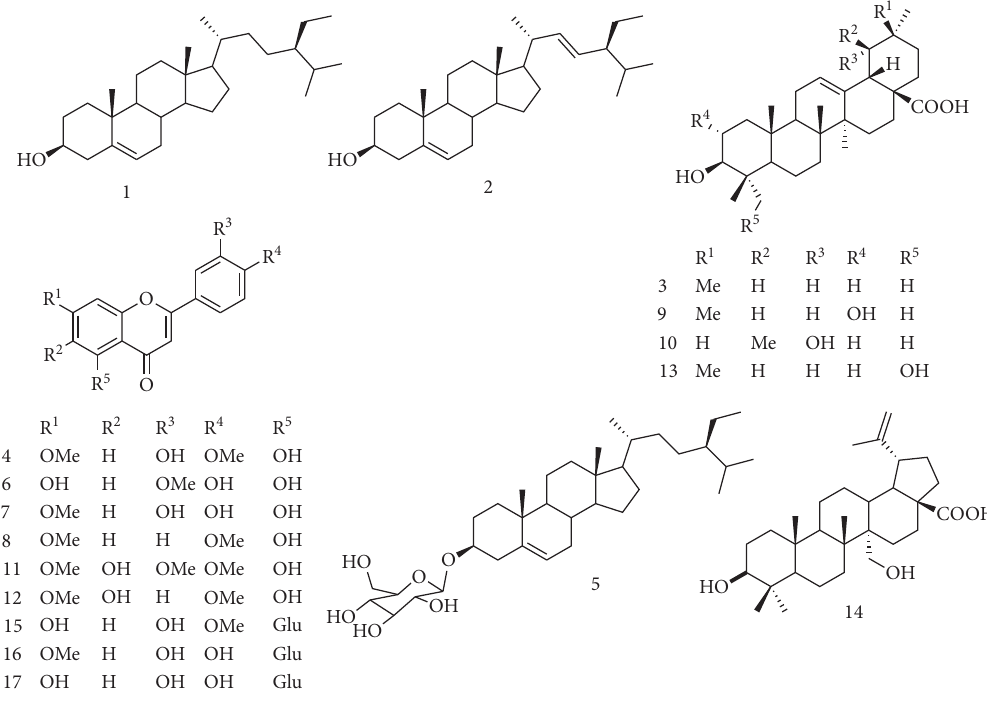
Figure 1: Structures of isolated compounds 1–17. Table 1: Minimum inhibitory concentration (MIC) and minimum bactericidal concentration (MBC) in μ g/mL of crude extracts and fractions from P. glandulosus and chloramphenicol against selected Gram-negative bacteria. Tested samples, MICs (MBCs) in μ g/mL Bacteria Extract Fraction B Fraction C